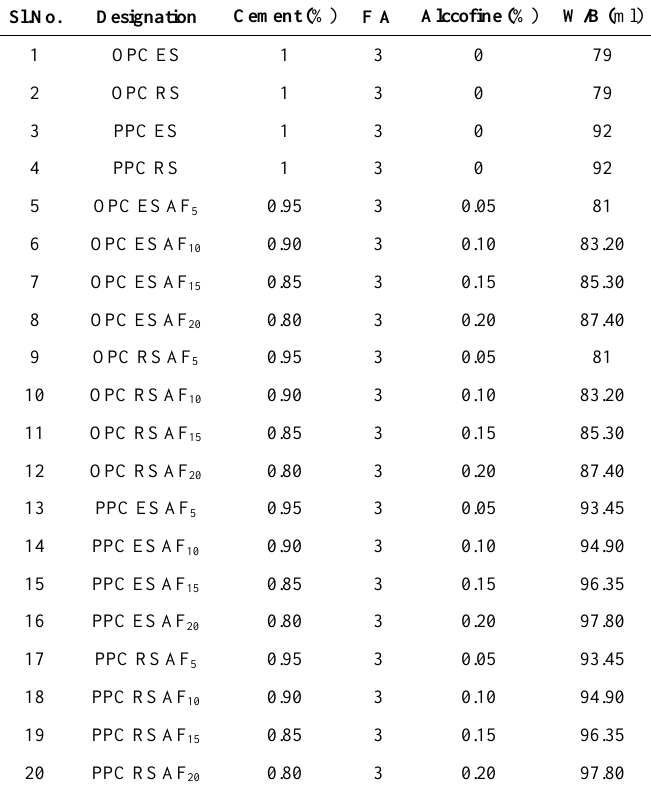
Table 6. Mix proportion for cement mortar cubes.